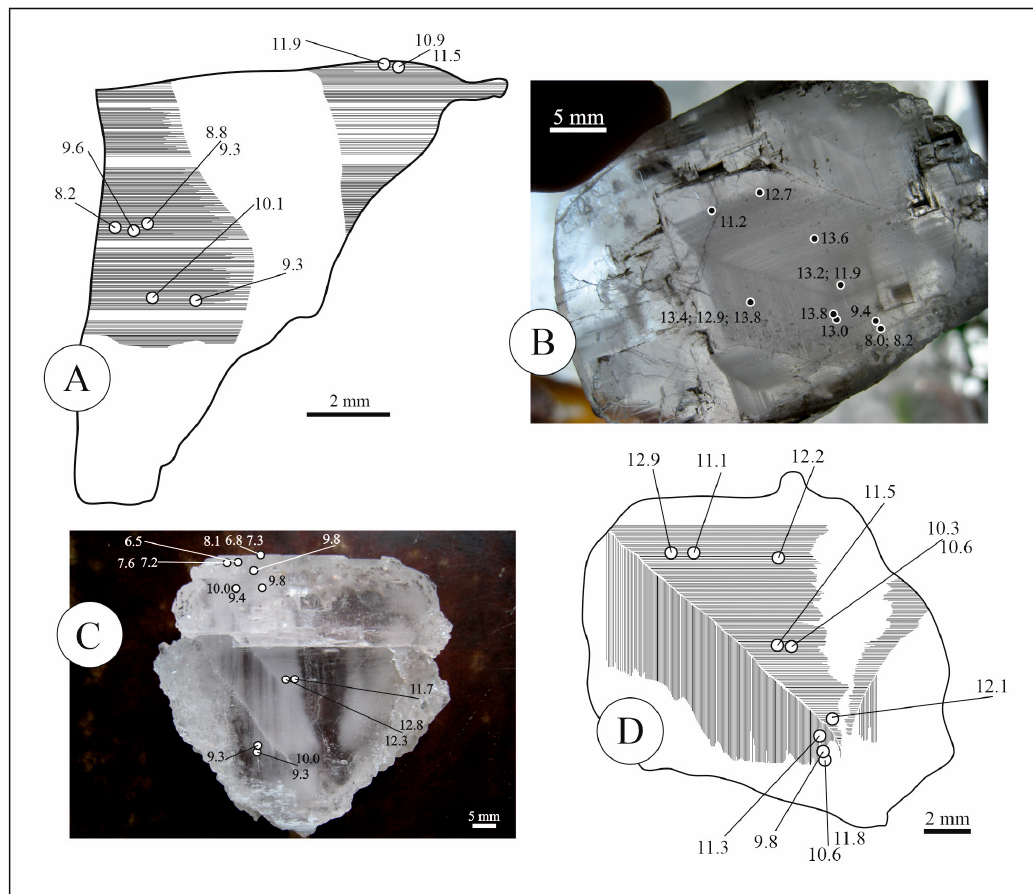
Figure 6. Chevron halite crystals from the Badenian Forecarpathian Basin. Dots show the locations of the investigated primary fluid inclusions, with the K + contents within the halite; plate numbers correspond to those in Table 2. ( A ) Drawing of chevron halite from the Forecarpathian Basin, Ukraine. Well Hrynivka 525, depth 422 m, sample, no. 1358. ( B ) Chevron halite crystal from Forecarpathian Basin, Poland. Wieliczka Salt Mine, sample from boulder of the Laminated Green Salt. ( C ) Fragment of halite chevron crystal from Spiza Salts series, Wieliczka Salt Mine. ( D ) Drawing zonation of chevron halite from Shaft Salt layer, Wieliczka Salt Mine.